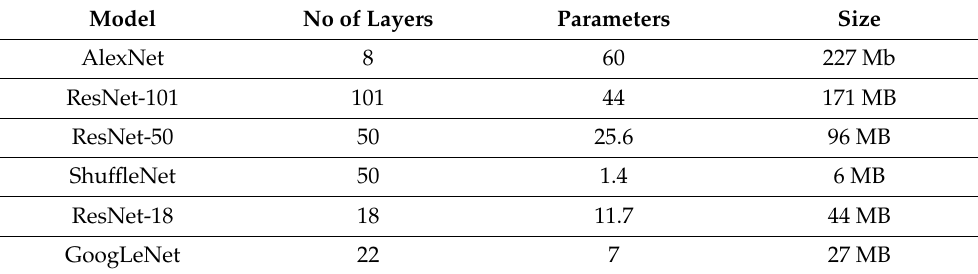
Table 3. Presents different layers and parameters along with size of various CNN